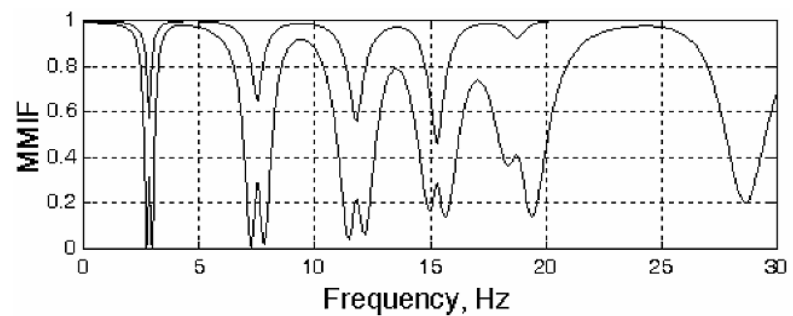
Fig. 13. MMIF for the 11-dof